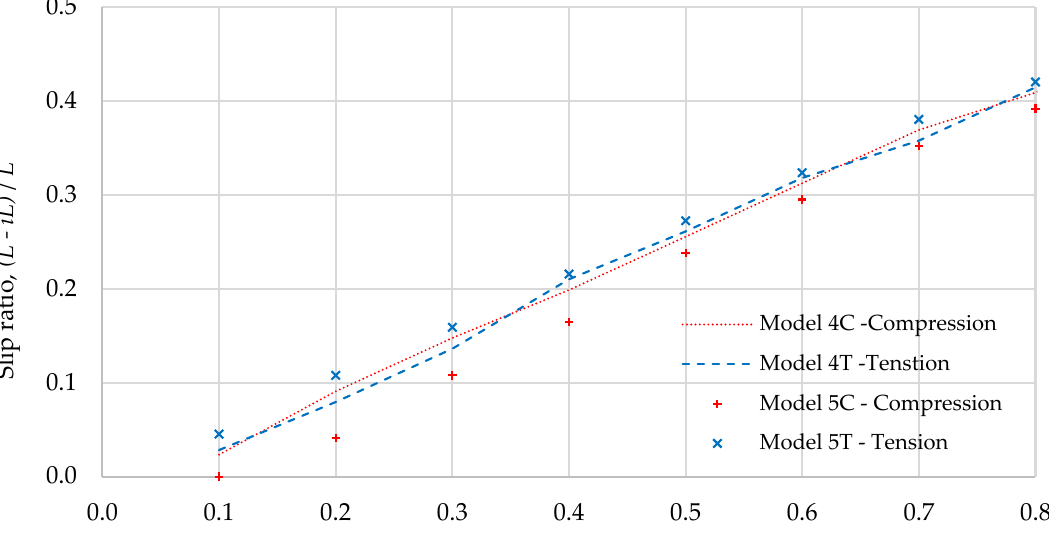
Figure 12. Slip ratio (slip depth to pile length) versus stress ratio at the mid-depth level of the pile.